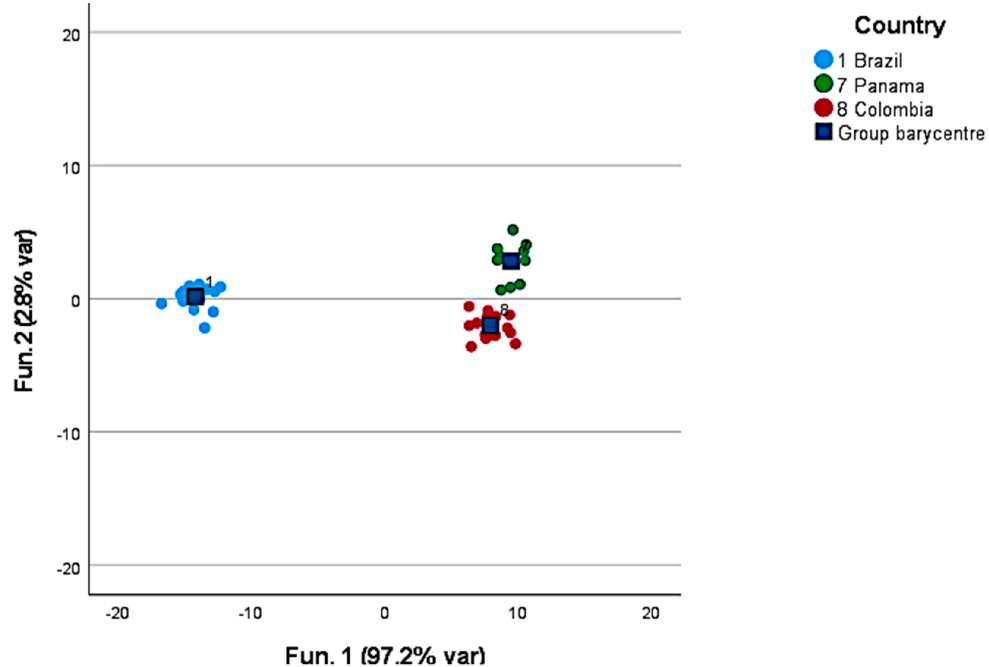
Figure 2. Discrimination of Brazilian, Colombian, and Panamanian green coffee in the American subcluster.